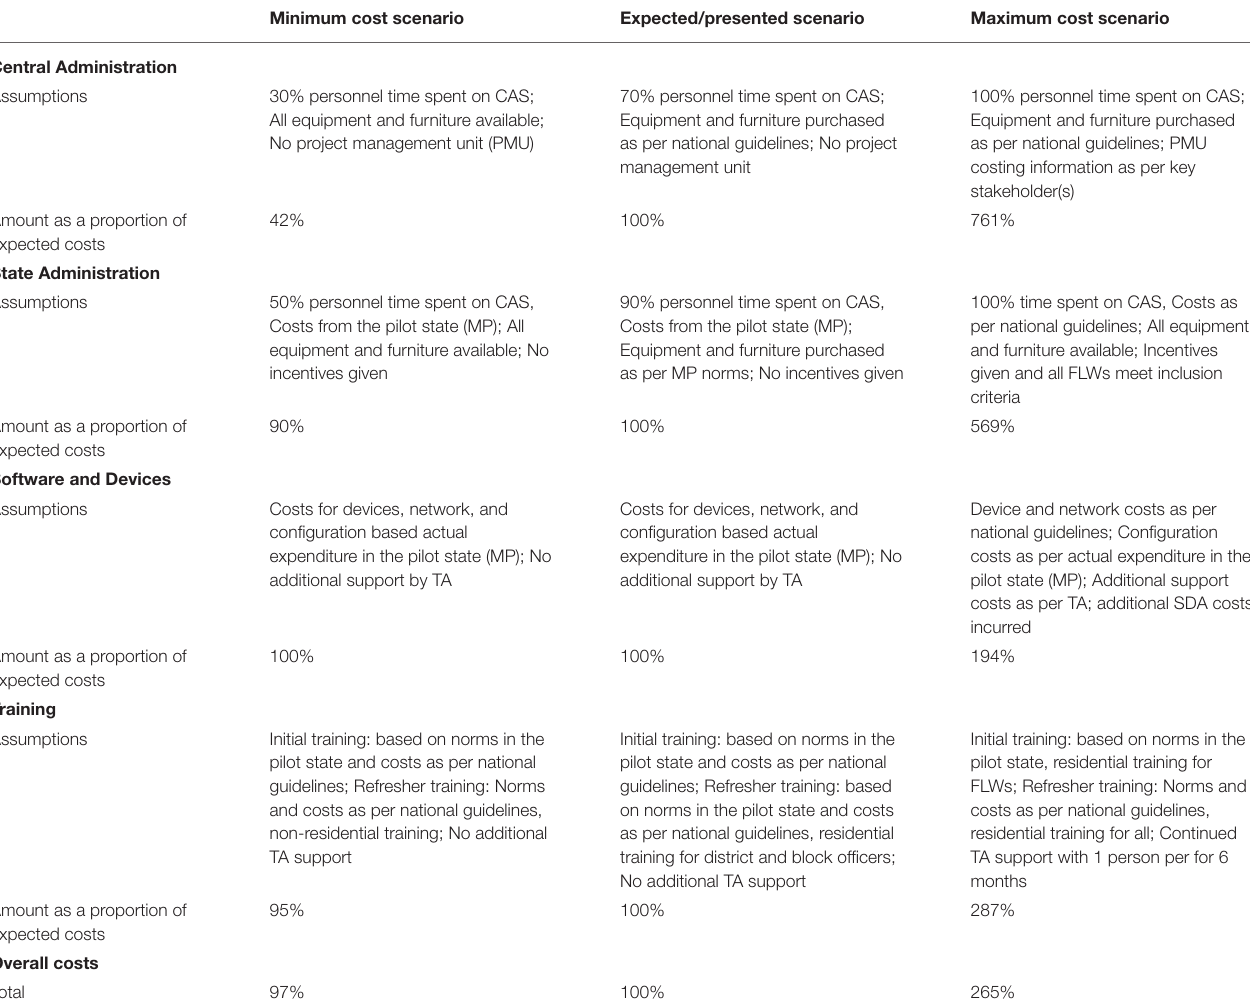
TABLE 3 | Cost variability as a proportion of expected costs due to changes in assumptions: an